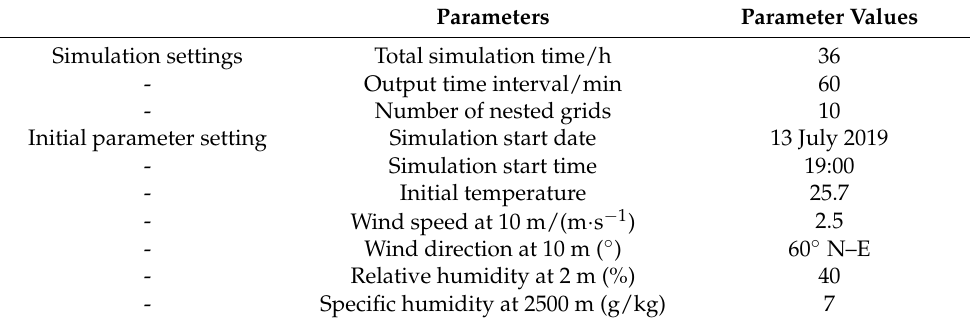
Table 2. The basic parameters of the simulation experiment. Parameters Parameter Values Simulation